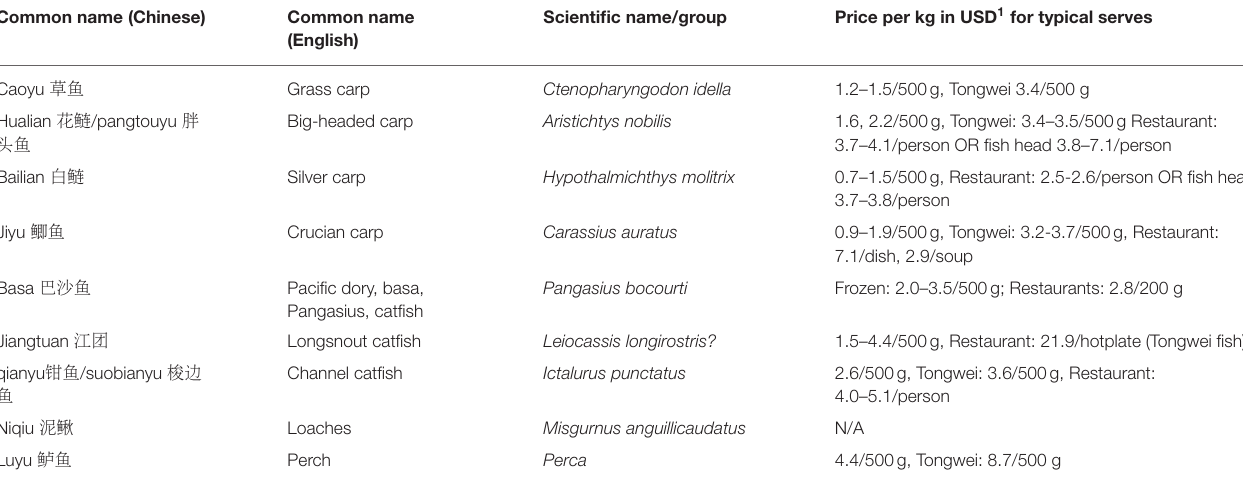
TABLE 1 | Commonly consumed freshwater fish in